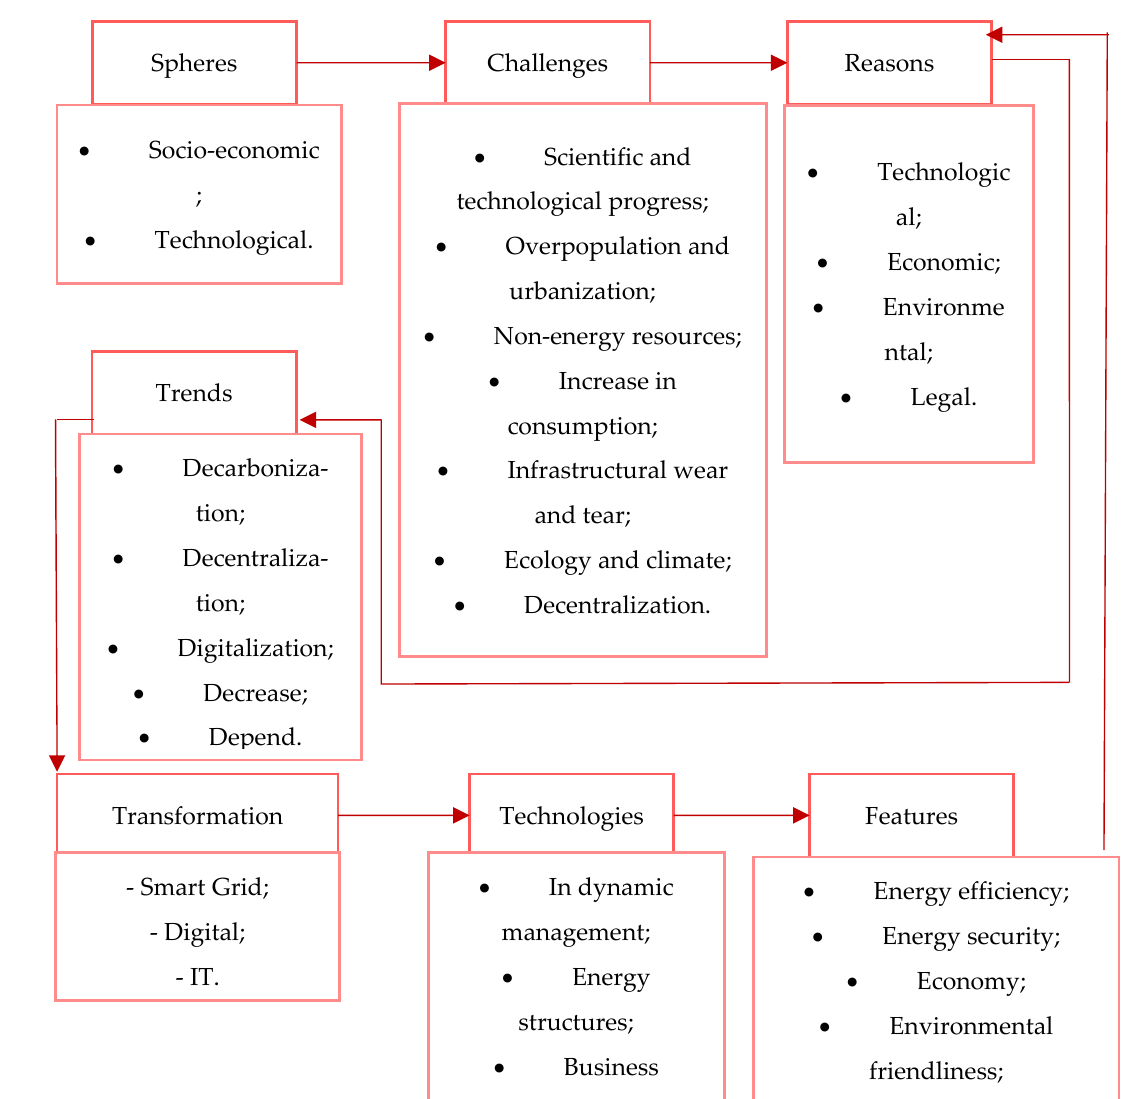
Figure 10. Model for assessing the impact of global challenges on technological development in the field of digital technologies and intelligent energy [40] (pp. 82–86).